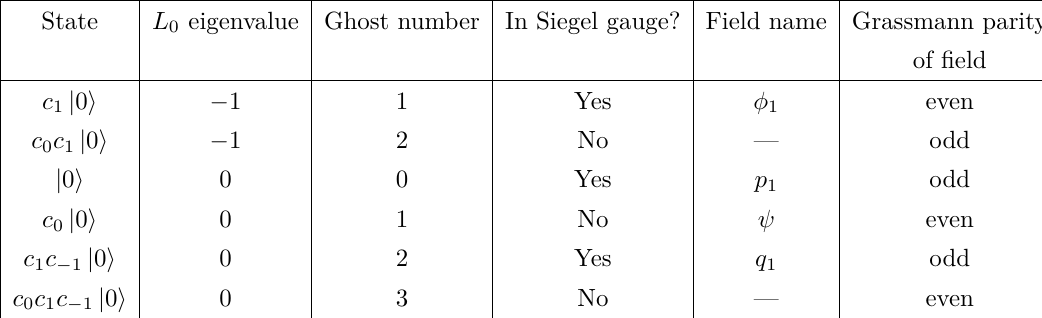
Table 1 . A list of states that are relevant for the discussion of divergences in the cylinder diagram. We have ordered the states first by their L 0 eigenvalues and then by their ghost numbers. A state and the corresponding field appear multiplied together in the expansion of the open string field as | Ψ i = φ 1 c 1 | 0 i + . . .